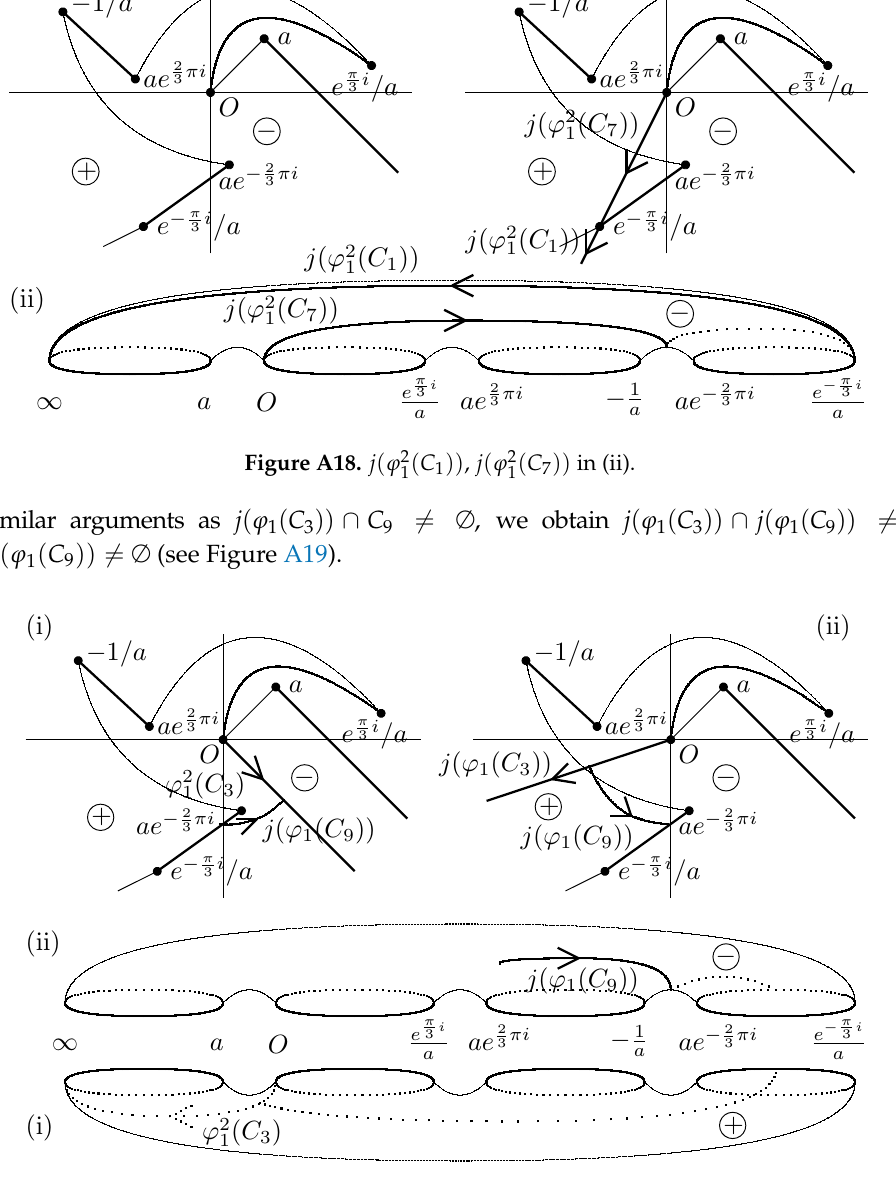
( C 3 ) , j ( ϕ 1 ( C 9 )) in M 1